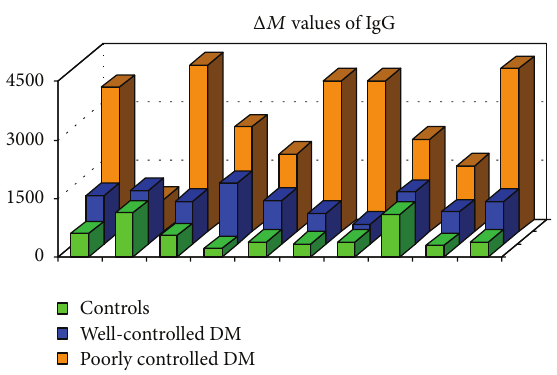
Figure 3: Δ𝑀 values of IgG obtained for healthy (first line), well- controlled diabetic patients (second line), and poorly controlled diabetic patients (third